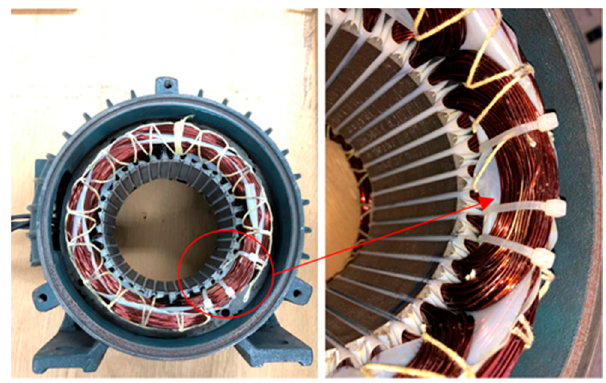
Figure 8. Stator winding inter-turn short circuit.